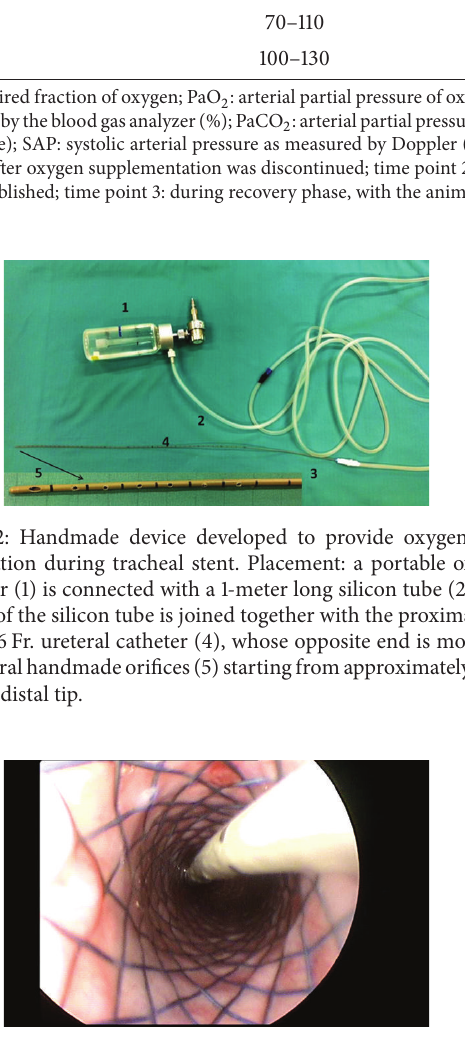
Figure 3: Endoscopic view of the tracheal lumen during the intraluminal stent placement. The white tube is the ureteral catheter used to provide oxygen